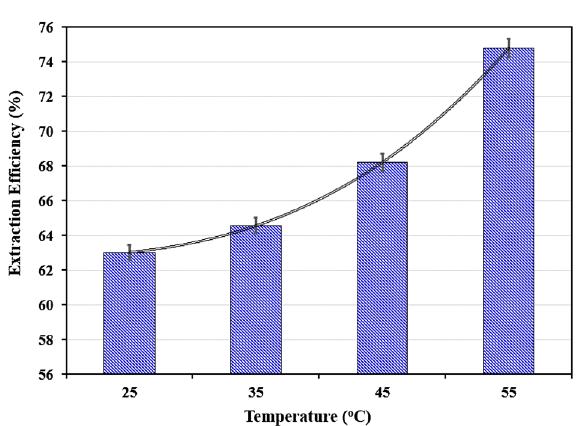
Figure 9. Effect of temperature on the extraction of Co(II) (Time = 30 min, Co(II) = 500 ppm, PEG = 50% w/w, (NH 4 ) 2 SO 4 = 4 M, pH =